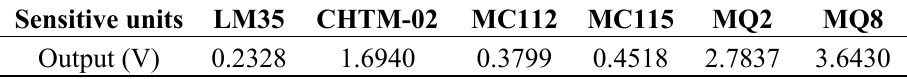
Table 6. First static measurements in Figure